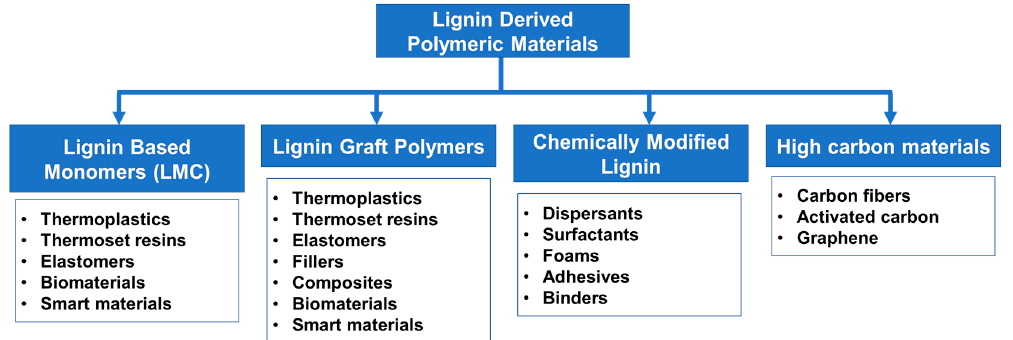
Figure 6. Lignin valorization via polymeric transformations.